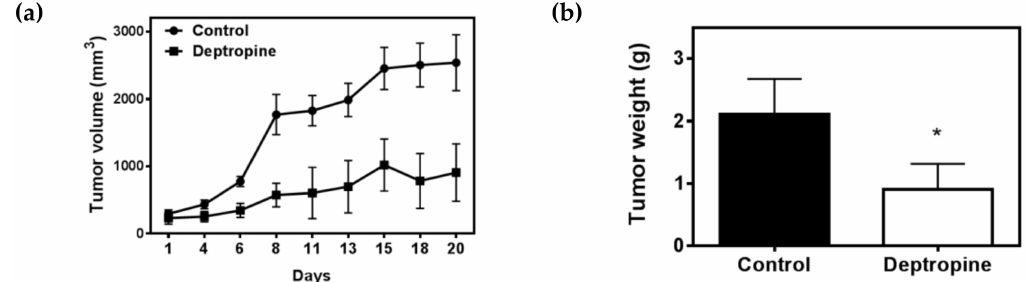
Figure 7. E ff ects of deptropine on hepatoma tumor xenografts in nude mice. Hep3B cells were subcutaneously injected between the scapulas of athymic nude mice, and the mice received an intraperitoneal (i.p.) injection of 2.5 mg / kg deptropine three times a week for 3 weeks. ( a ) The tumor volume was measured every 2 or 3 days, and ( b ) the tumor weight was measured at the end of the experiment. Values were obtained from seven or eight samples, and results are presented as the mean ± standard error. * p < 0.05 vs. the control.